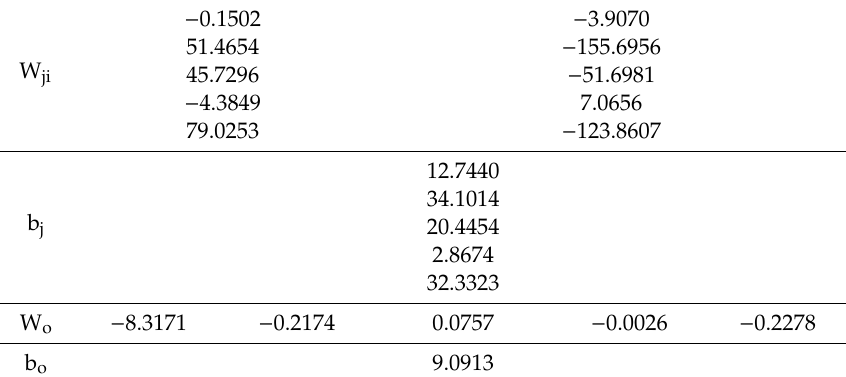
Table 2. Parameters of